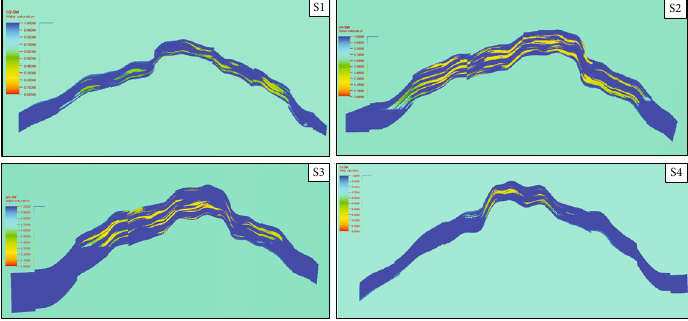
Figure 17: Longitudinal cross-sections of the S1 ~ S4 water saturation models.